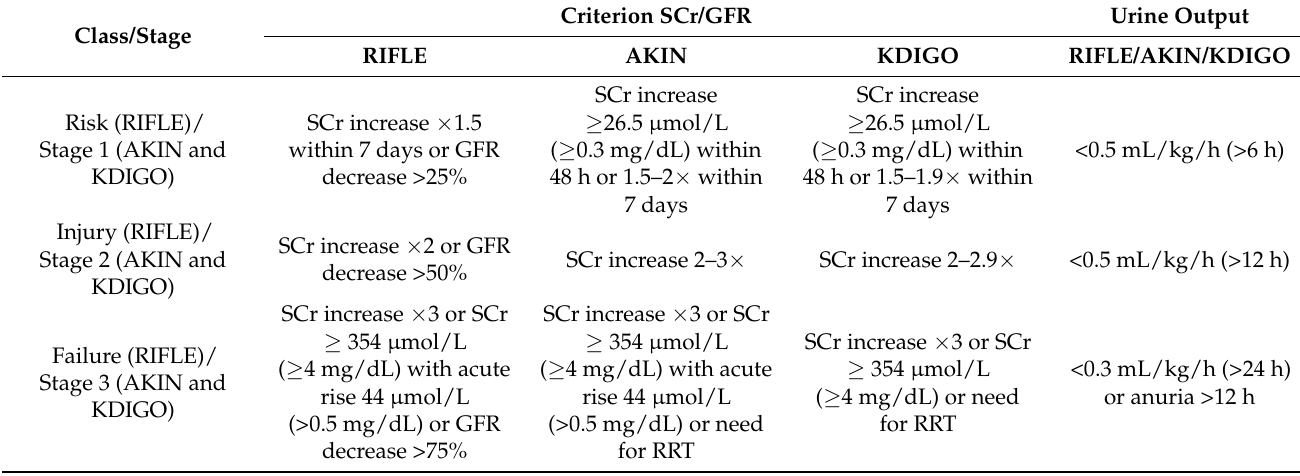
Table 1. Diagnostic criteria for AKI according to RIFLE, AKIN and KDIGO. RIFLE, Risk Injury Failure Loss and End-Stage Renal Failure; AKIN, Acute Kidney Injury Network; KDIGO, Kidney Disease: Improving Global Outcomes; Scr, serum creatinine; RRT, renal replacement